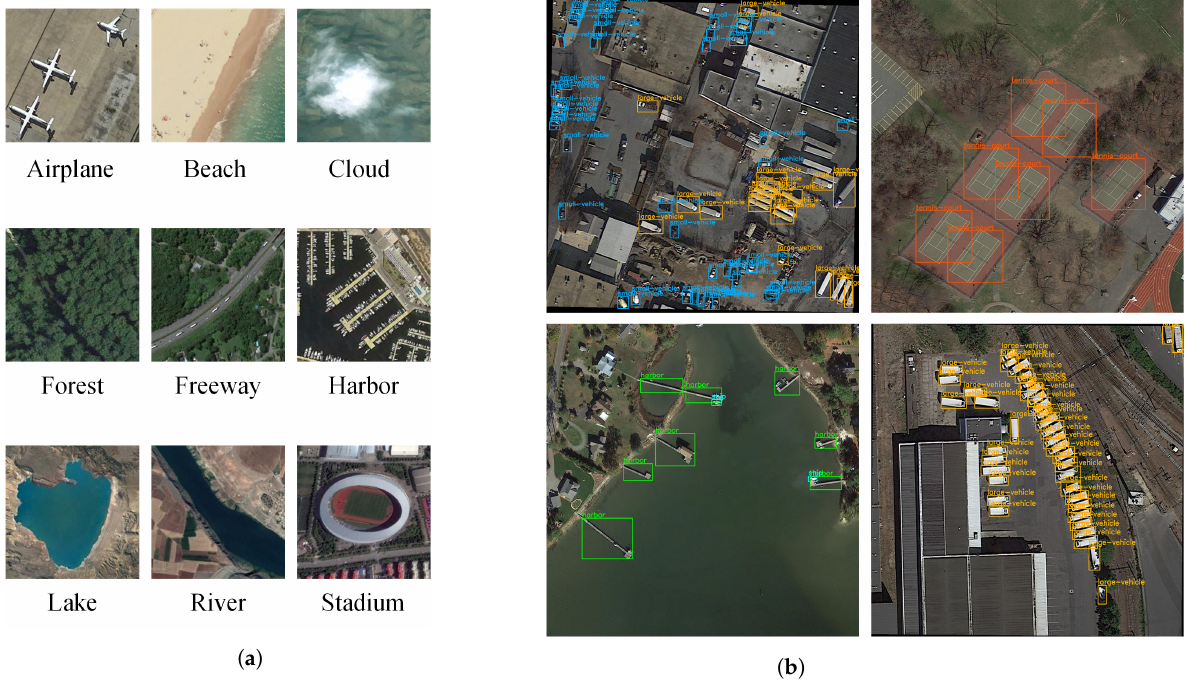
Figure 20. ( a ) Samples of the results of classification; ( b ) samples of the results of